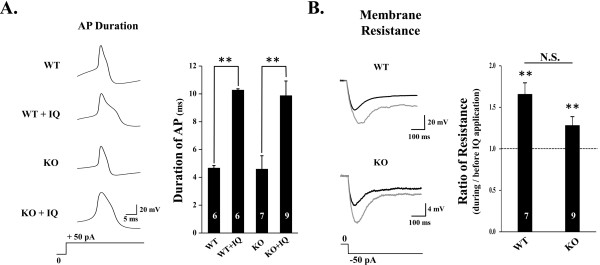
Effects of IQ on AP duration and membrane resistance of DRG neurons in WT and TLR7 KO mice. A. Representative trace of AP of DRG neuron from WT and TLR7 KO before and after application of IQ. Bar graph indicates the average of AP duration of DRG neurons with or without IQ treatment from WT and TLR7 KO mice. B. Left column shows the representative example of change of membrane resistance induced by injection of negative current. Average effect of IQ on membrane resistance compared with WT and KO is shown as bar graph. Protocol for AP induction and membrane resistance by current injection was shown in bottom of traces of A and C. The number in each bar indicates the number of neurons. Error bars indicate S.E.M. (**, P > 0.01).